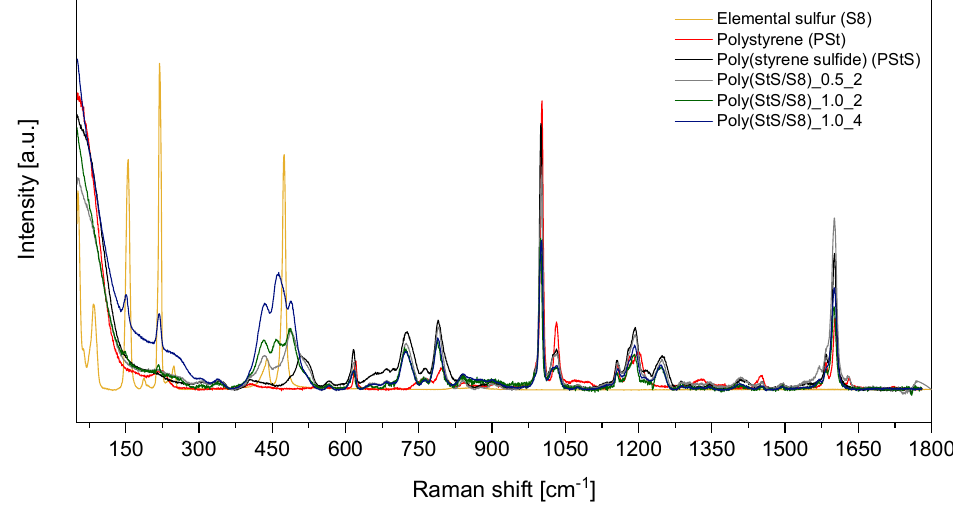
Figure 4. Raman spectra of synthesized polysulfides with different sulfur content. The spectra registered for elemental sulfur and reference polystyrene were added for comparison.